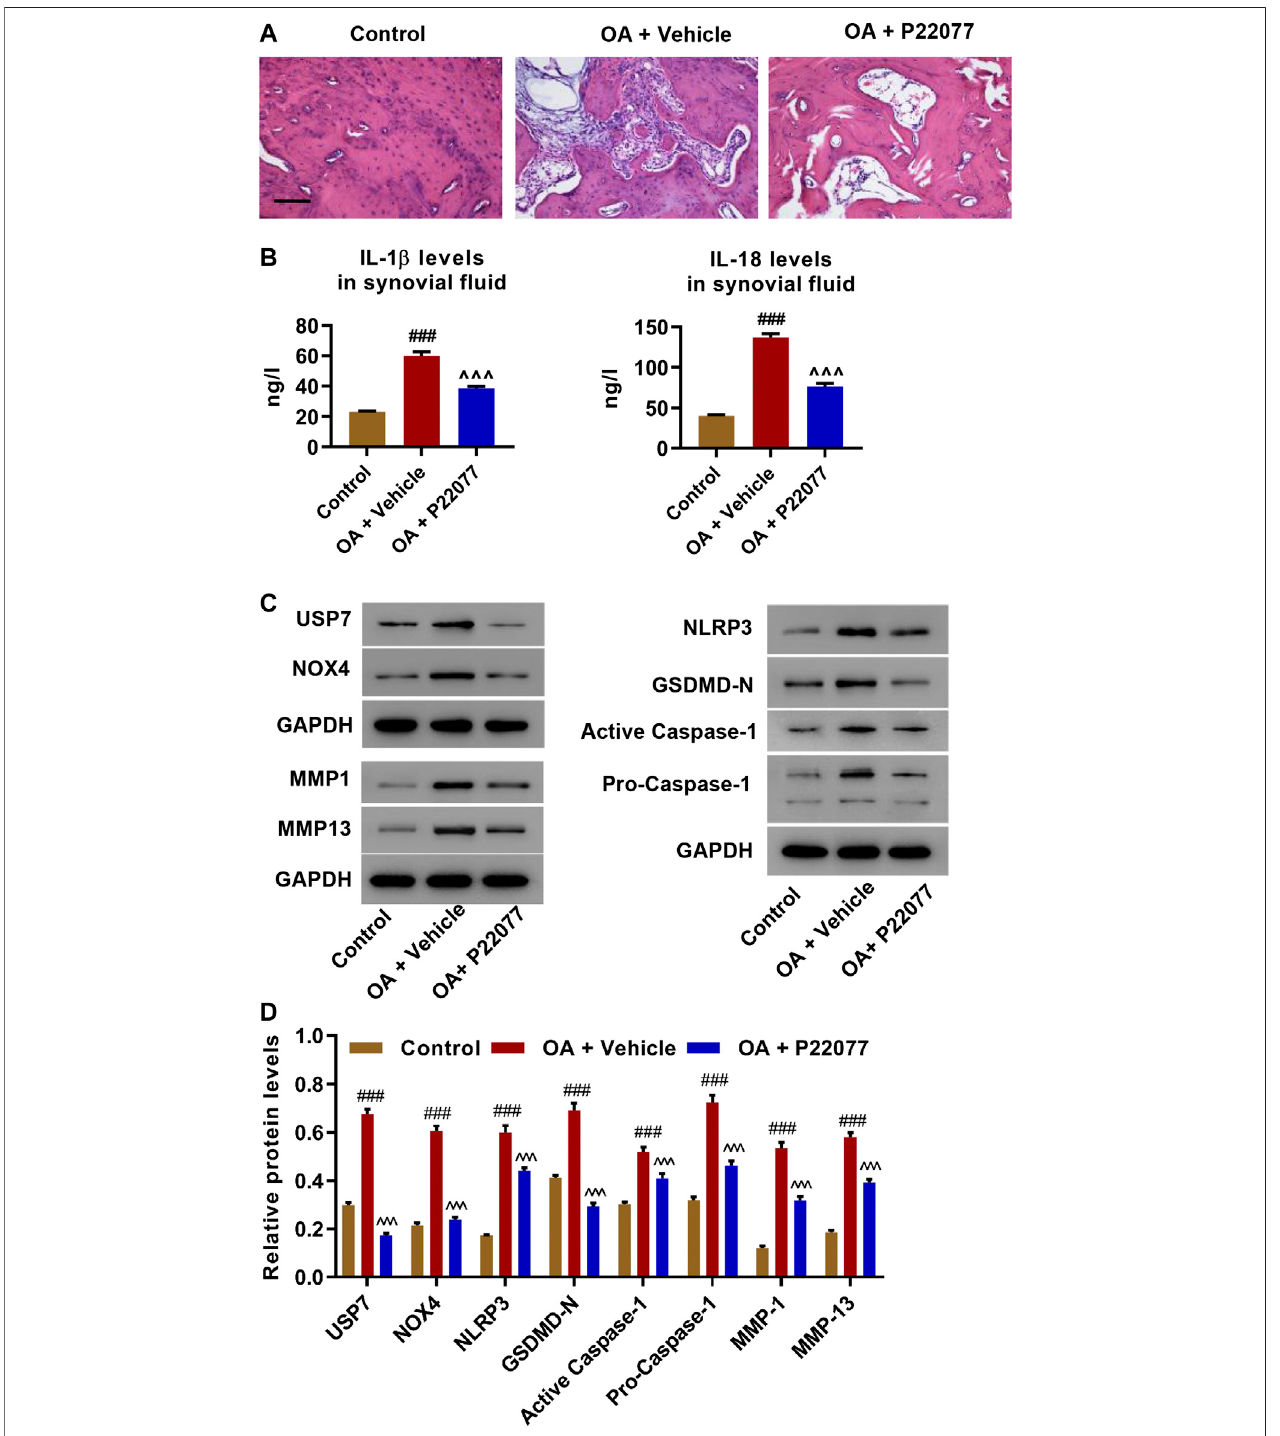
FIGURE 6 | USP7 inhibition suppressed the OA process in vivo . Rats were injected with monosodium iodoacetate (MIA) to establish an OA model with or without P22077 treatment, and (A) H and E staining, (B) IL-1 β and IL-18 levels, and (C,D) expression levels of USP7, NOX4, NLRP3, GSDMD-N, active caspase-1, pro- caspase-1, MMP1, and MMP13 were measured. ### p < 0.001 vs control; ^^^ p < 0.001 vs OA + vehicle.